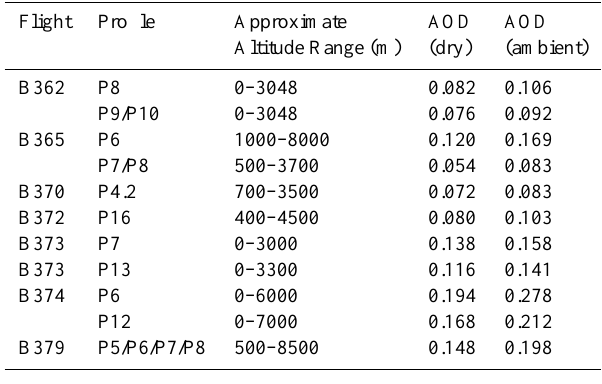
Table 4. Optical depths at 550 nm calculated from the most com- plete scattering profiles for dry and ambient aerosol (scattering cor- rected using the measured growth factor).